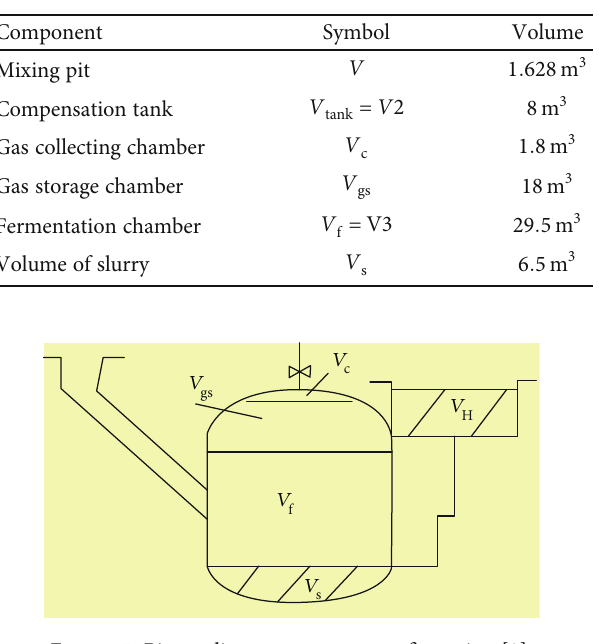
Table 8: Digester component volume and diameter.